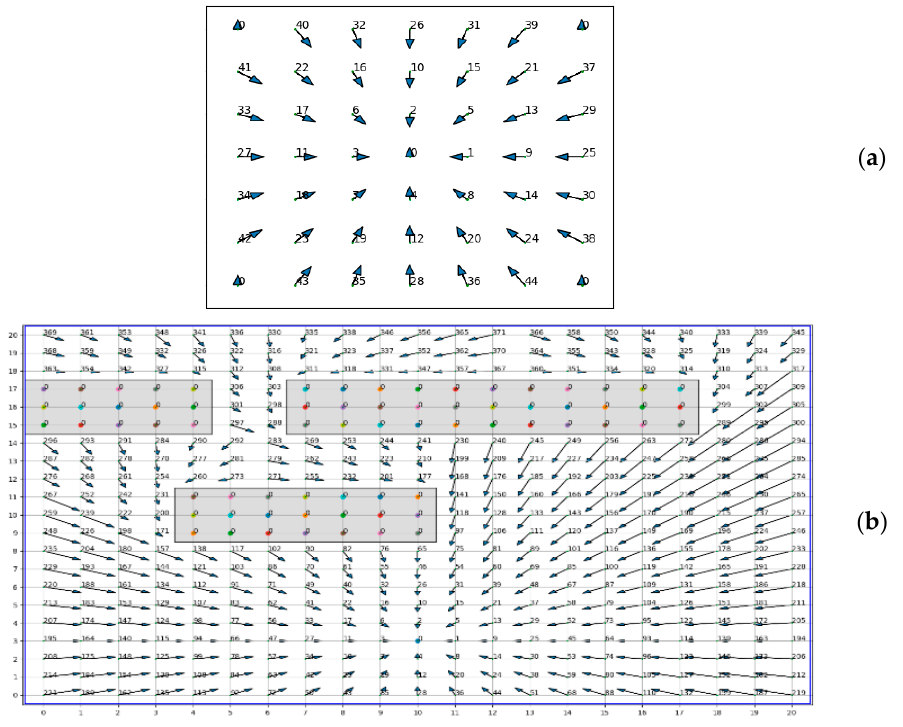
Figure 5. Progress of shortest distance propagation: ( a ) visited 44 cells, ( b ) visited 371 cells.